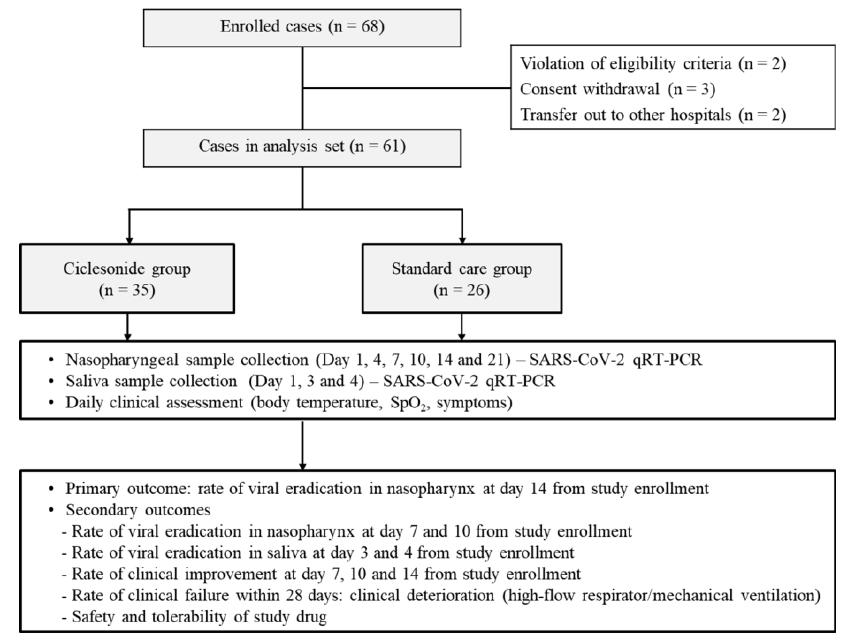
Figure 1. Study flowchart: randomization and treatment